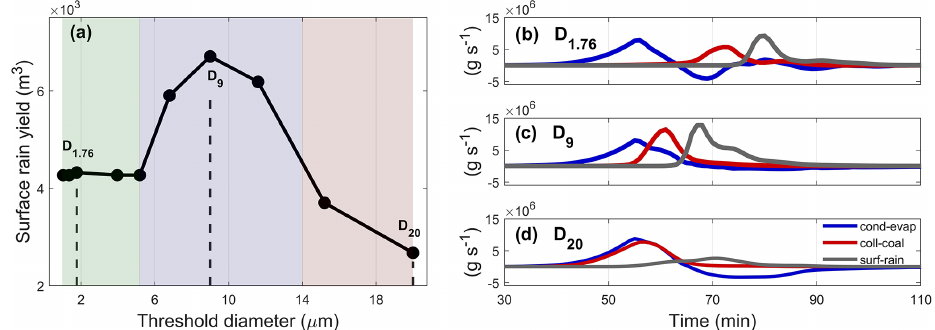
Figure 4. (a) Surface rain yield (m 3 ) as a function of a threshold diameter (no particles bigger than that diameter) for the Atlantic-1 MSD. Each circle in panel (a) represents a subtraction of specific bins from the MSD. The shaded areas indicate the different regimes of surface rain yield. (b–d) Condensed–evaporated mass (blue), collected mass (red), and surface rain rate (gray) per unit time, as a function of time for selected threshold diameters matching three simulations from panel (a) . The specific threshold diameters are marked in the upper left corner of each panel ( D 1 . 76 , D 9 , and D 20 µm: b – d , respectively), and panel (d) represents the full Atlantic-1